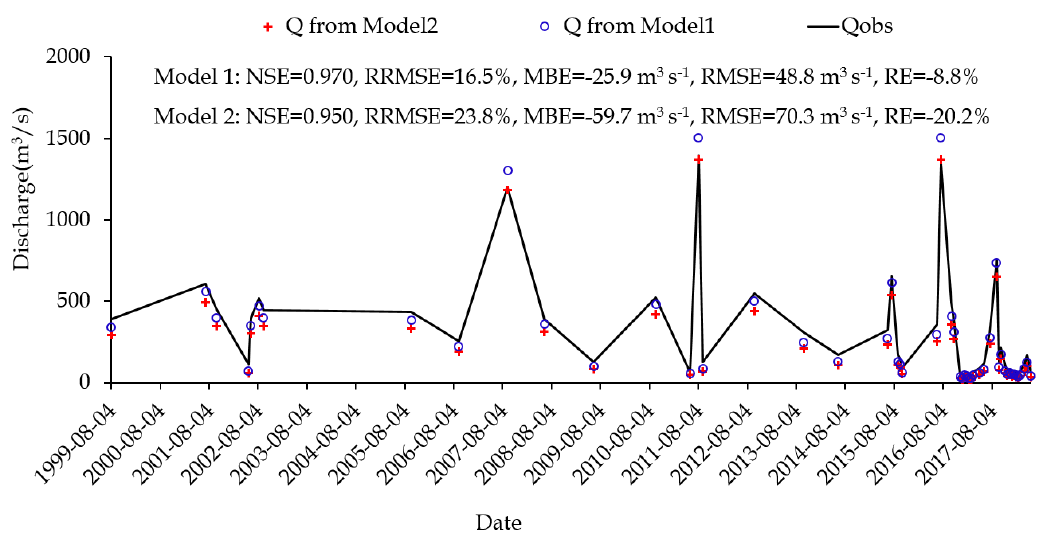
Figure 12. A time series plot to show comparison of observed and estimated (via Model 1 and Model 2) discharge at Tanggya gauge for further validation of the methodology over the study period of 1999–2018.The discharge estimation using Model 1 and Model 2 had nicely captured the observed flow pattern consistently indicating the possible applicability of the methodology in different channel morphologies.